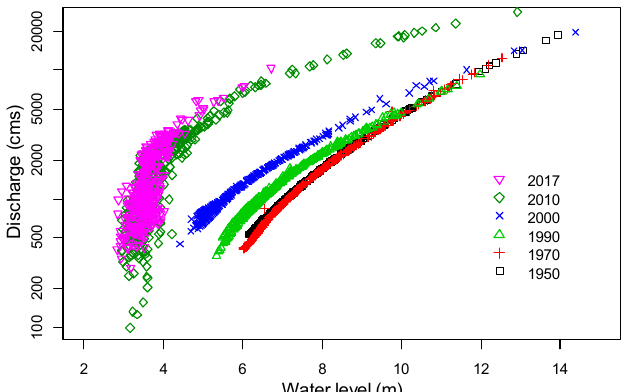
Figure 11. The stage-discharge rating curves at Zhuqi station in different years.